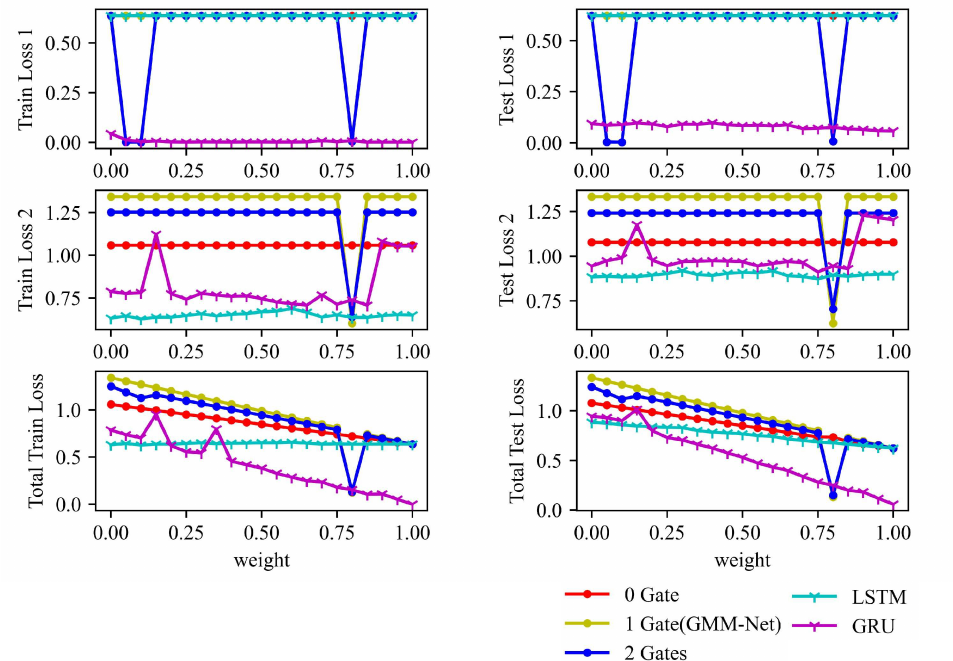
Figure 10. Final train and test losses of five models by changing the weight ω